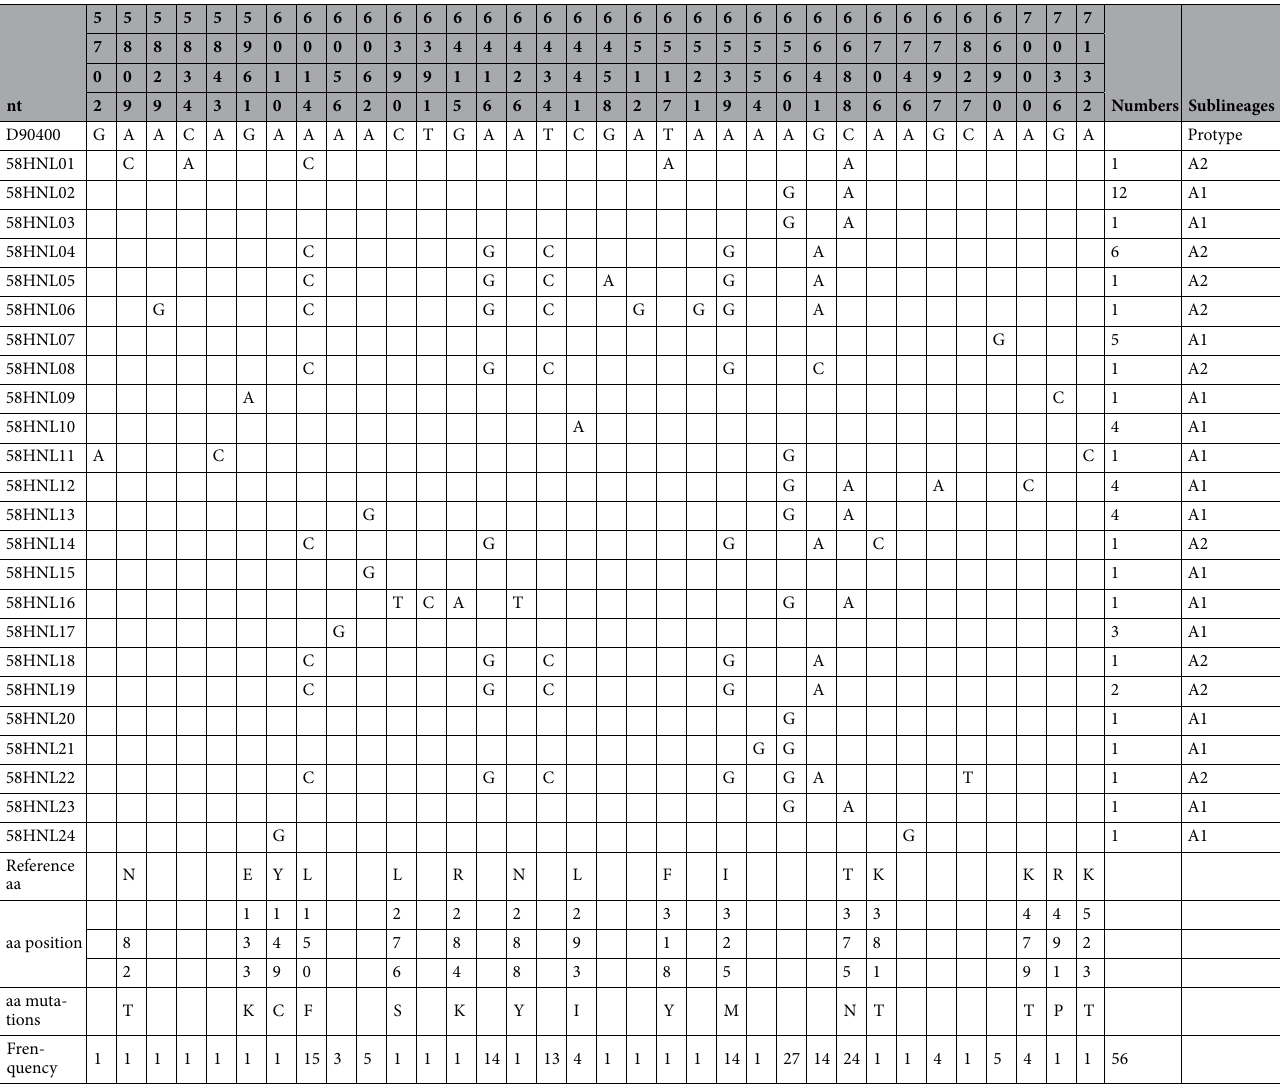
Table 3. Nucleotide sequence mutations of HPV58 L1 genes. Positions without variants are marked with blank, whereas positions with variants are indicated by a